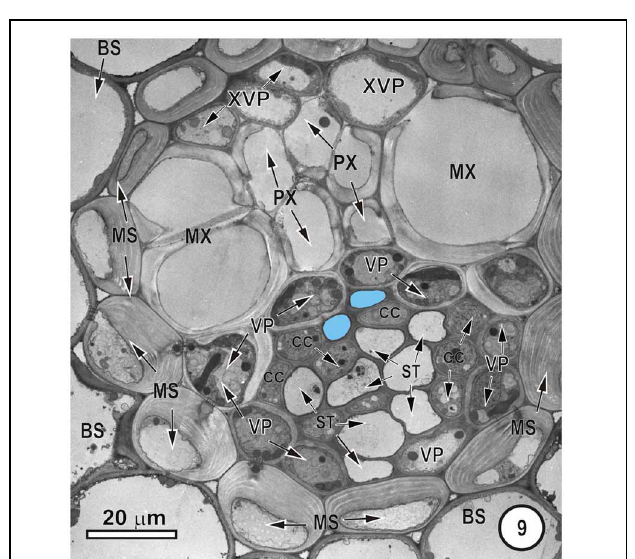
FIGURE 9 | Intermediate vascular bundle in the leaf blade of Mariscus congestus (Cyperaceae). The vascular tissue is surrounded by two sheaths—an outer parenchymatous bundle sheath (BS) and an inner lignified mestome sheath (MS). Note extreme thickening of inner tangential walls of MS cells. Only two thick-walled sieve tubes (pale blue fill), that are separated from the MX by a single row of XVP. MX are associated with smaller protoxylem vessels (PX). STs are associated with companion cells (CC) and are bordered by VP. FUNCTIONAL RELATIONSHIPS WITHIN VASCULAR BUNDLES;